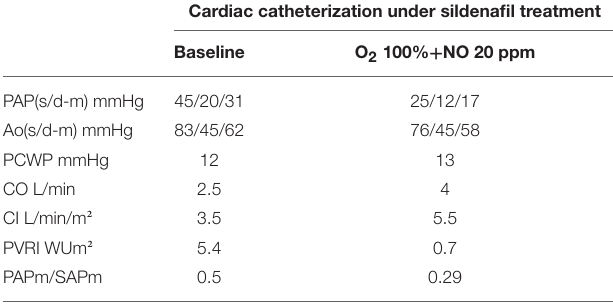
TABLE 1 | Cardiac catheterization with vasoreactivity